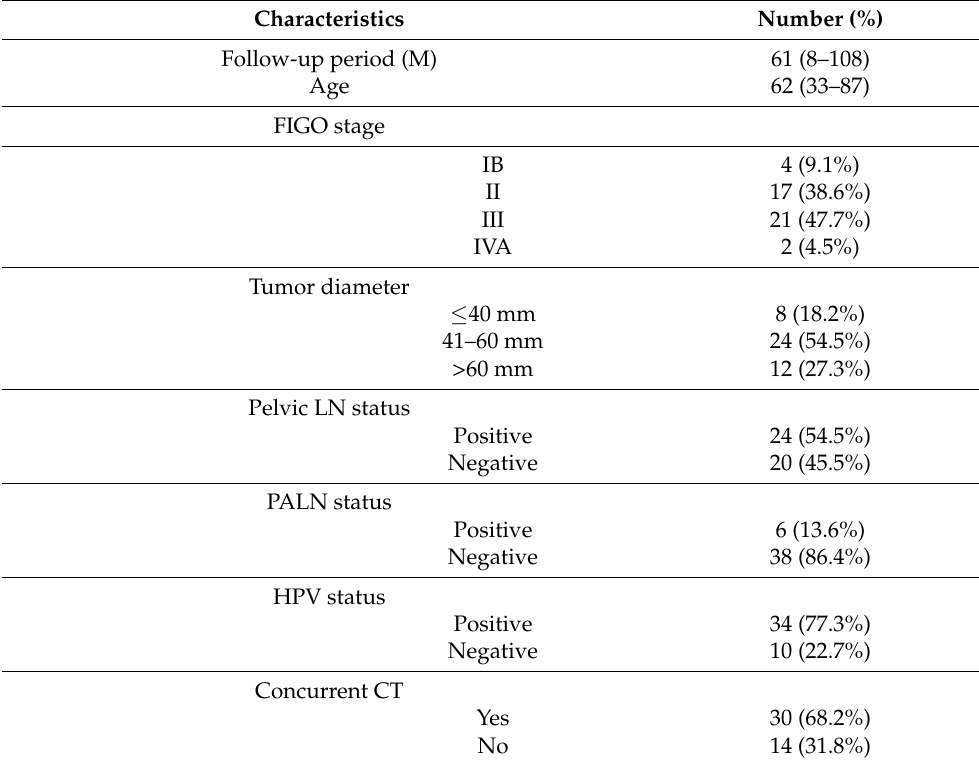
Table 1. Patient characteristics ( n =